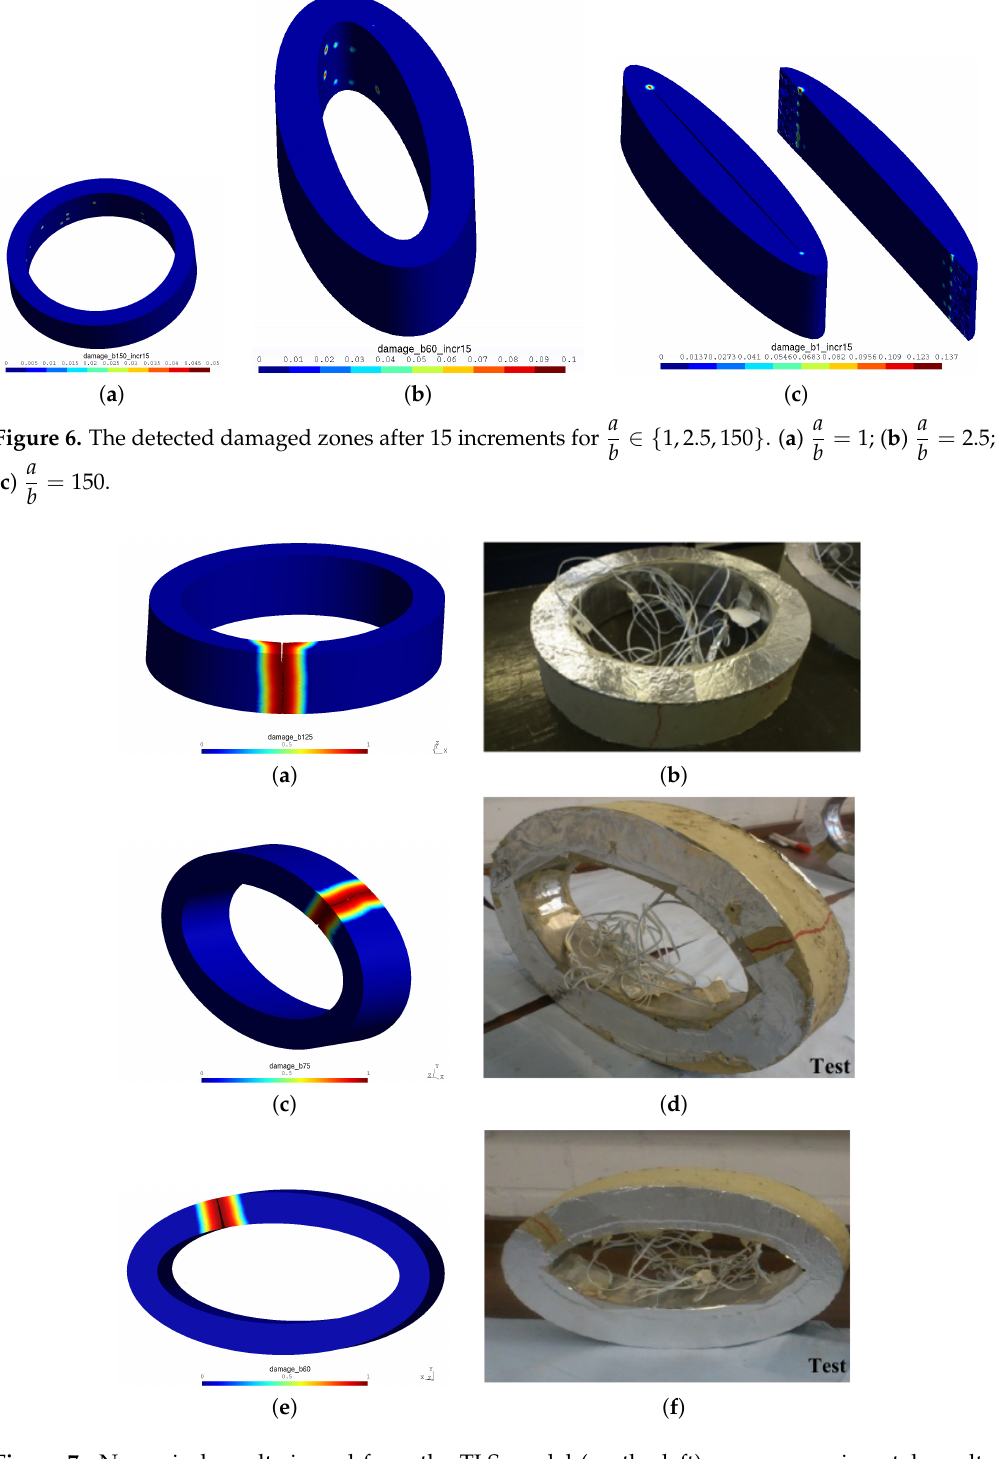
a ∈ { 1.2,2,2.5 } . ( a ) b